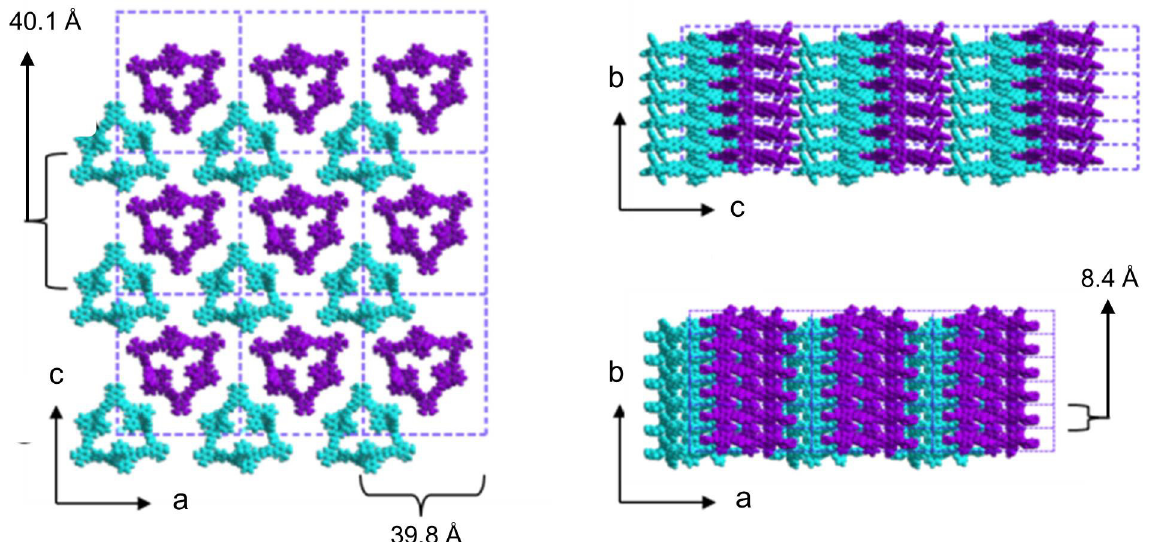
FIGURE 10 - Proposed fiber packing model for triangle 20 [Schultz, A.; Cao, Y.; Huang, M.; Cheng, S. Z. D.; Li, X.; Moorefield, C. N.; Wesdemiotis, C.; Newkome, G. R. Dalton Trans. , v.41, p.11573-11575, 2012. – Reproduced by permission of The Royal Society of